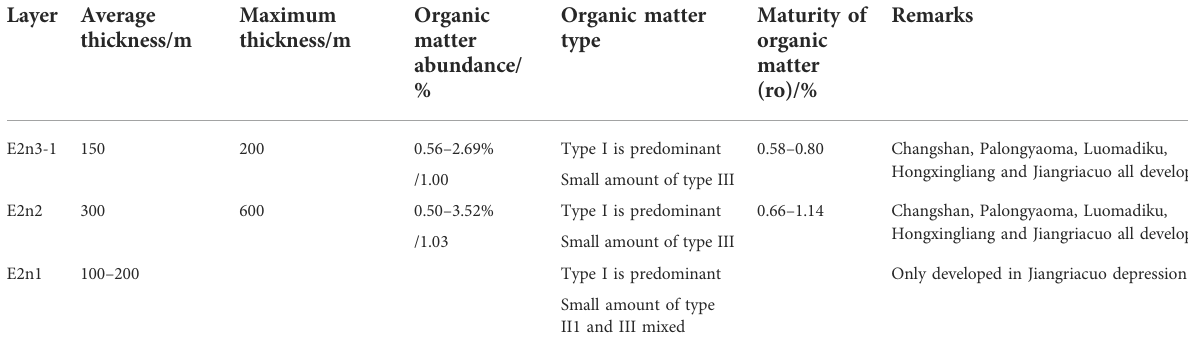
TABLE 2 Characteristics of main source rocks in the lumpura